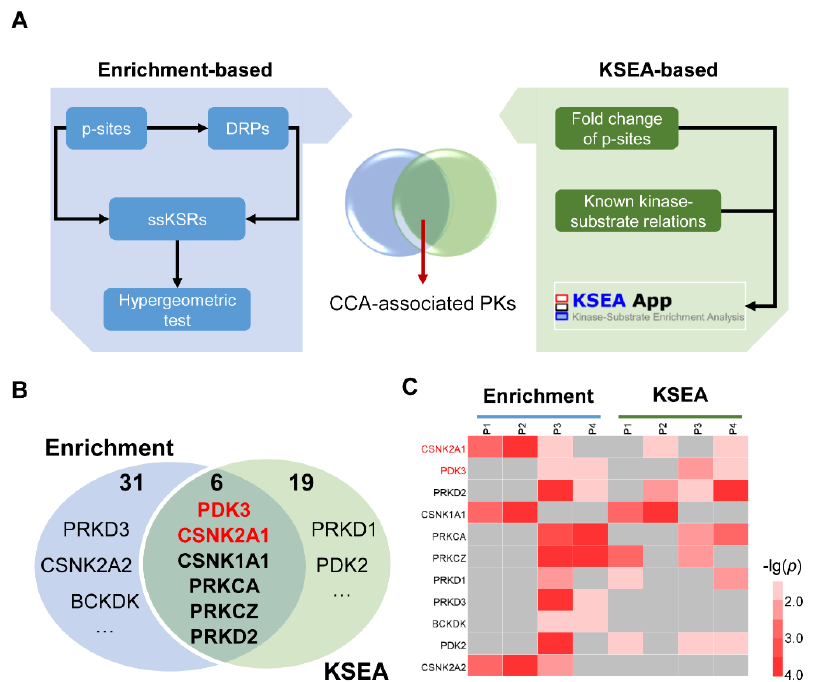
Figure 4. The prediction of CCA − associated PKs with CifPK pipeline: ( A ) the procedure of the CifPK pipeline, including the enrichment − based analysis, KSEA-based prediction, and the integration of PK candidates from two methods; ( B ) the Venn diagram of CCA − associated PKs predicted with enrichment − and KSEA − based method, with the known CCA − associated PKs shown in red; ( C ) the heatmap of differential dysregulation of 11 potentially CCA − associated PKs in CCA samples.